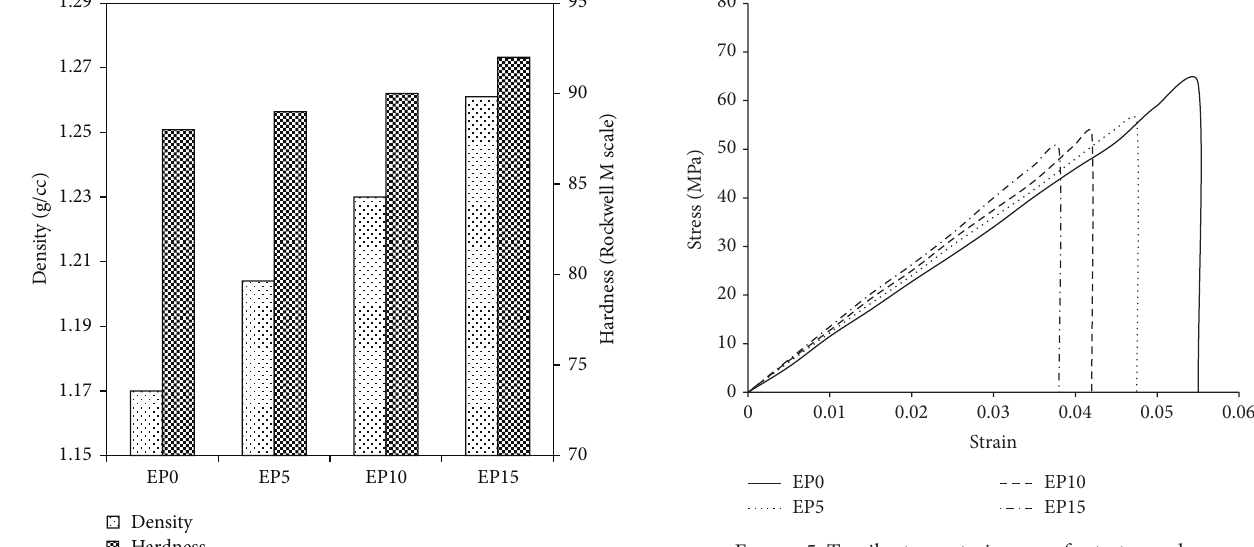
Figure 5: Tensile stress-strain curve for test